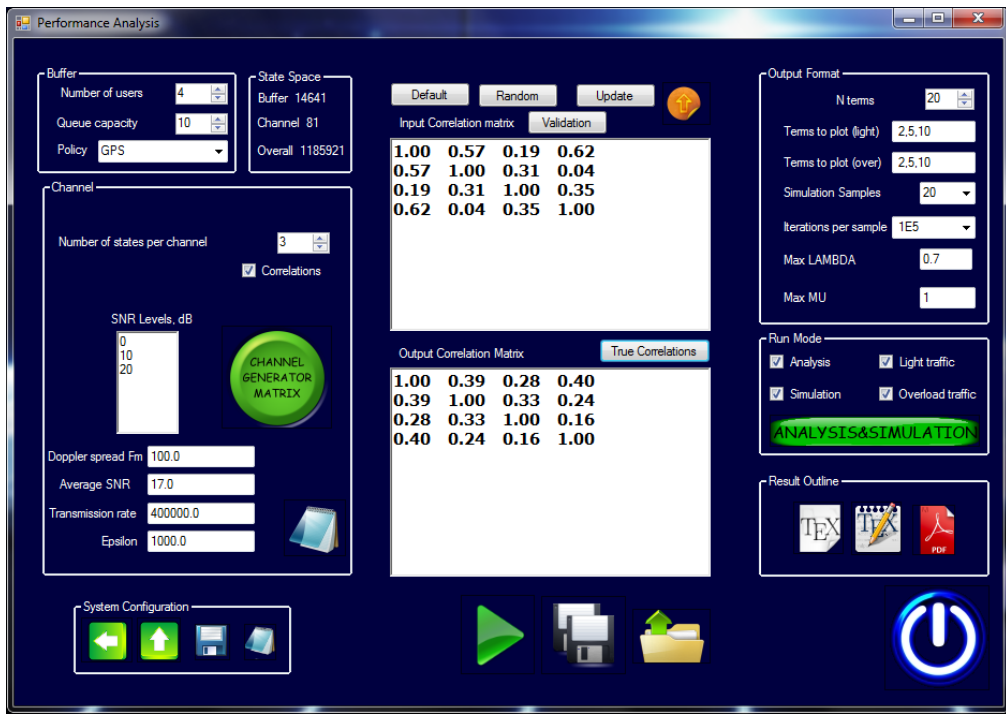
Figure 3: The graphical user interface allows for setting up the buffer and channel parameters